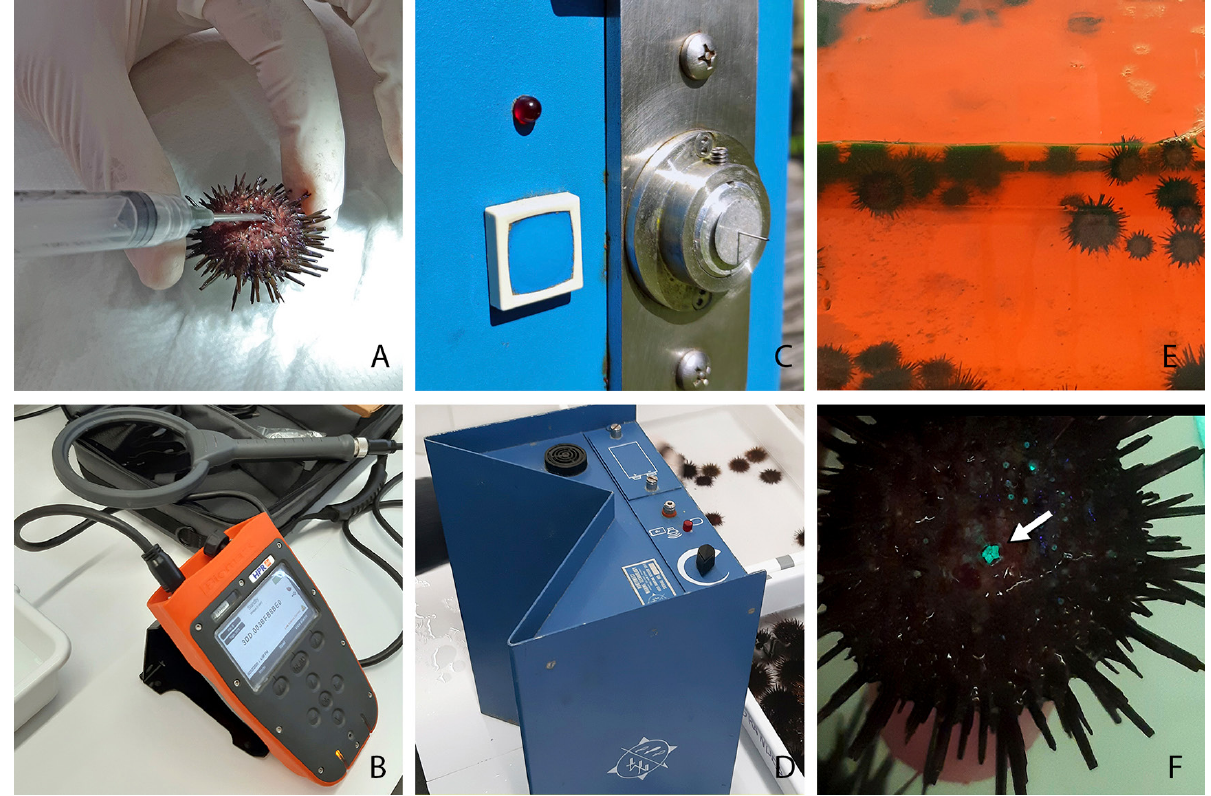
Fig. A4. – Photographs illustrating the PIT-tags, coded wire tags (CWT) and calcein used to tag Paracentrotus lividus for a 60-day experimental period in the laboratory. A, detail of the implantation of a Biomark HPT8 PIT-tag using a MK165 syringe with an N165 needle. B, the portable Biomark HPR Plus™ automatic reader used to detect PIT-tags in the coelomic cavity of the sea urchins. C, detail of the Mark IV Tag Injector, showing the CWT injection needle. D, the portable V-Detector (NMT), used to assess the presence of CWTs in the coelomic cavity. E, detail of the calcein bath (100 mg calcein L –1 ) applied to P. lividus for 24 h. F, P. lividus tagged with calcein immersion and maintained in a recirculating aquaculture system for 60 days. A green, fluorescent stain is visible on the exposed part of the Aristotle’s lantern (arrow) under UV light and yellow filter